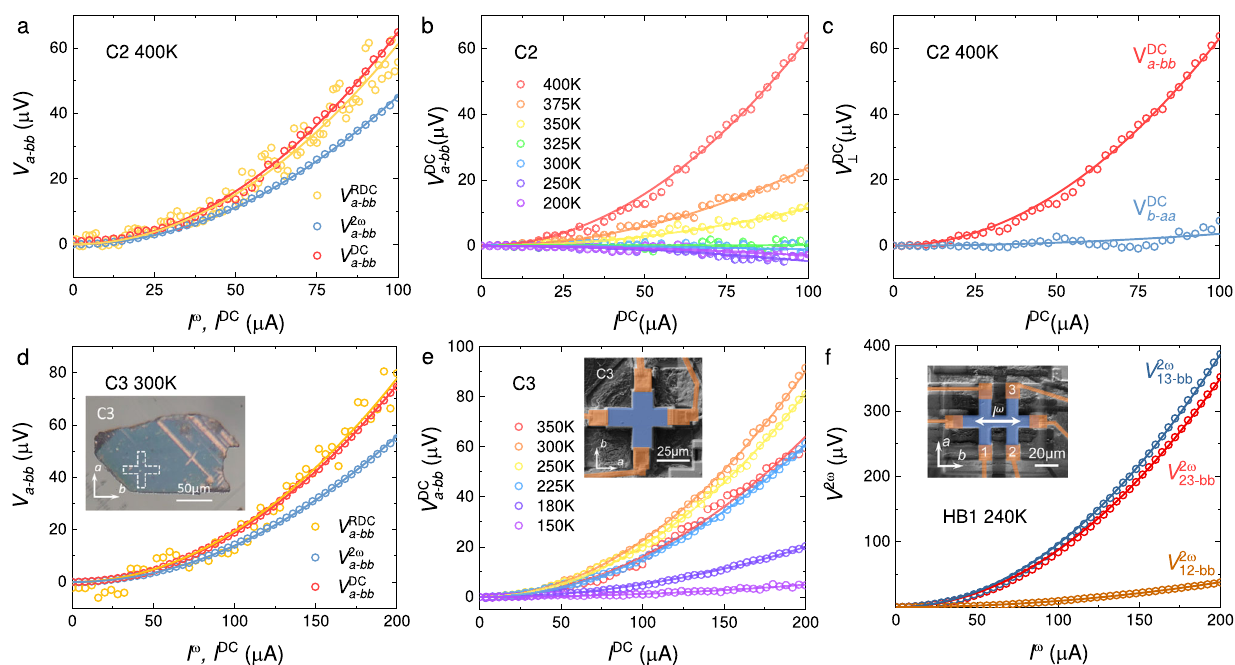
Fig. 3 | Recti fi ed Hall voltage response driven by ac, nonlinear Hall voltage response driven by dc, and nonlinear Hall angle of BaMnSb 2 . a The second- harmonic Hall voltage V 2 ω a (cid:2) bb , recti fi ed Hall voltage V RDC a (cid:2) bb , and dc-driven nonlinear Hallvoltage V DC a (cid:2) bb ofC2at400K. b V DC a (cid:2) bb atvarioustemperaturesforC2. c V DC - I DC characteristics at 400K for C2. V DC a (cid:2) bb and V DC b (cid:2) aa refer to V DC measured with the dc I DC applied along the b - and a -axis, respectively. d The second-harmonic Hall vol- tage V 2 ω a (cid:2) bb , recti fi ed Hallvoltage V RDC a (cid:2) bb , and dc-driven nonlinearHallvoltage V DC a (cid:2) bb